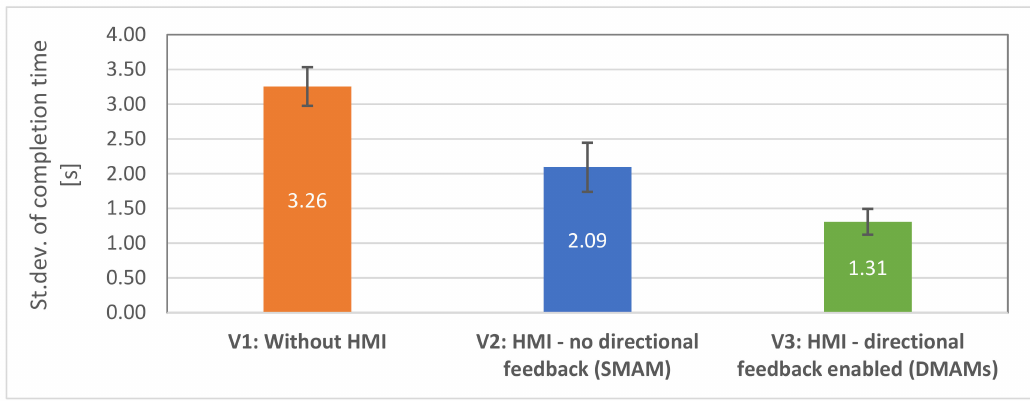
Figure 16. Standard deviations of the task completion time: lower is